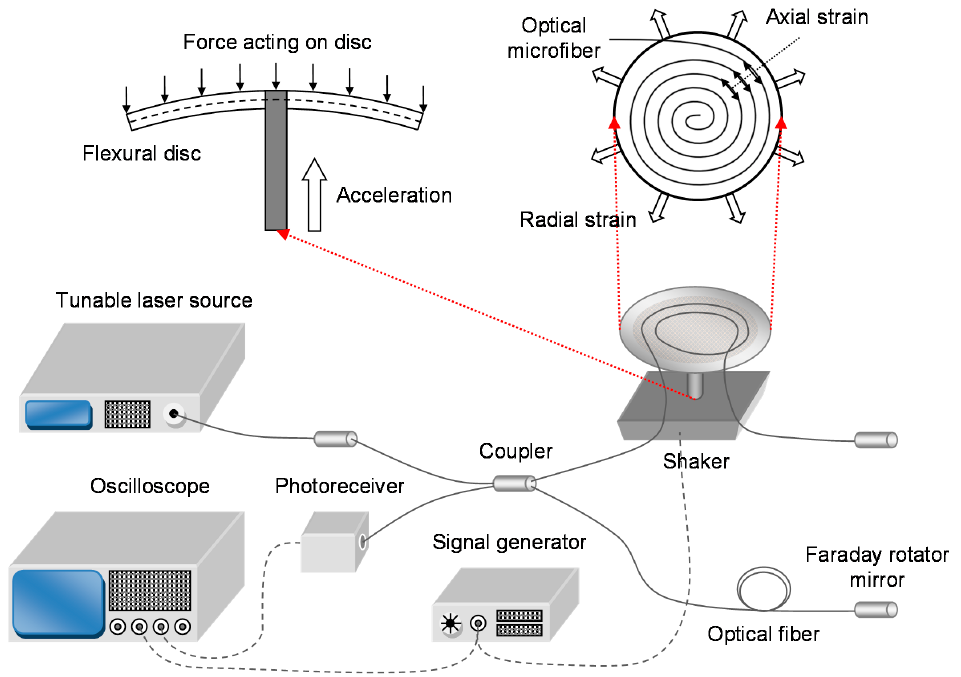
Figure 15. Schematic diagram of the experimental setup with the sensing mechanism illustrated.